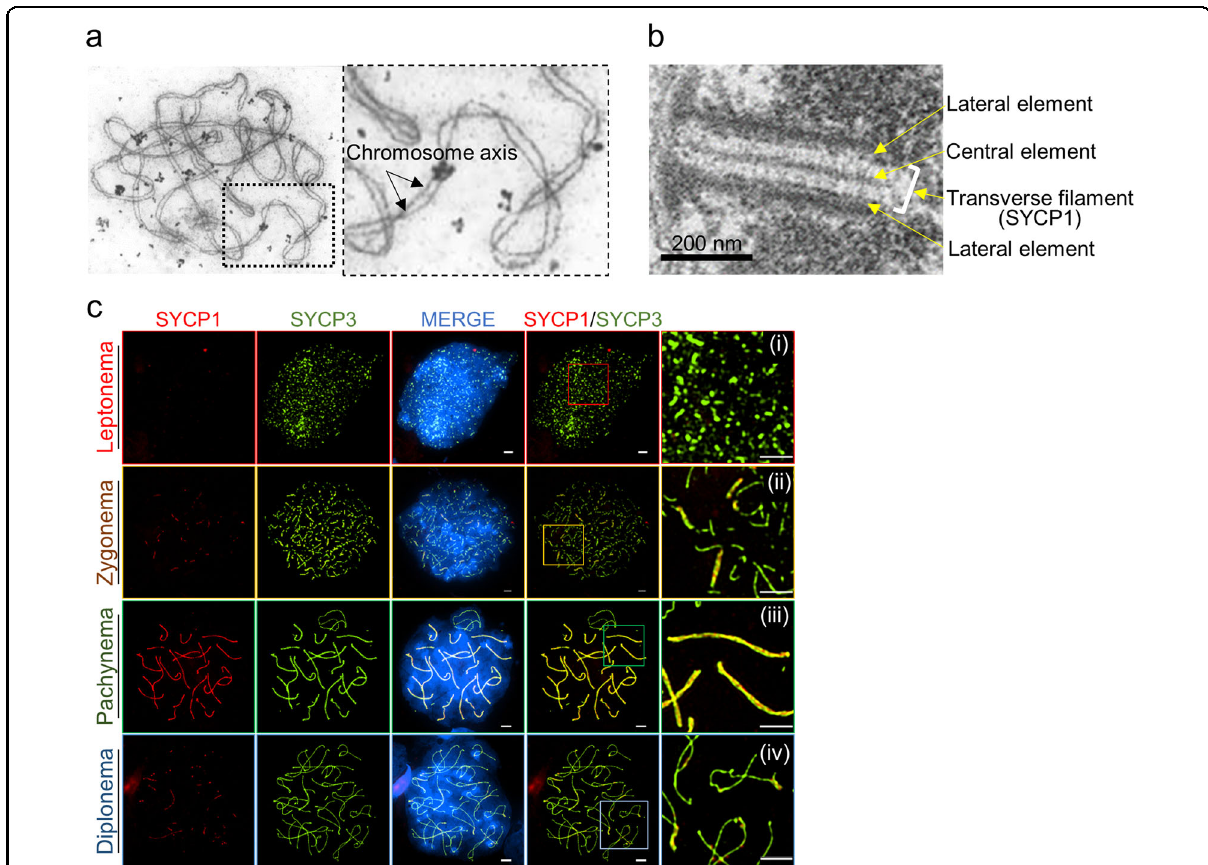
Fig. 1 Chromosome organization during meiotic prophase I. a Structure of pachynema chromosomes in Arabidopsis thaliana . Chromosome axes at the pachynema stage were observed in electron micrographs 64 . b Ultrastructure of mouse SC consisting of transverse fi laments with two lateral elements, separated by a central element (modi fi ed from Kouznetsova et al. 23 ). Scale bar represents 200 nm. c Localization of SYCP1 and SYCP3 on chromosomes in meiotic prophase I. Spermatocytes of C57/BL6J mice were used for chromosome spreads. Cytological progression through meiotic prophase I was analyzed by immunostaining with anti-SYCP3 and anti-SYCP1 antibodies. (i – iv) Magni fi ed views of overlay images from leptonema, zygonema, pachynema, and diplonema stages. SYCP3 was used to visualize chromosome axes for all stages of meiotic prophase